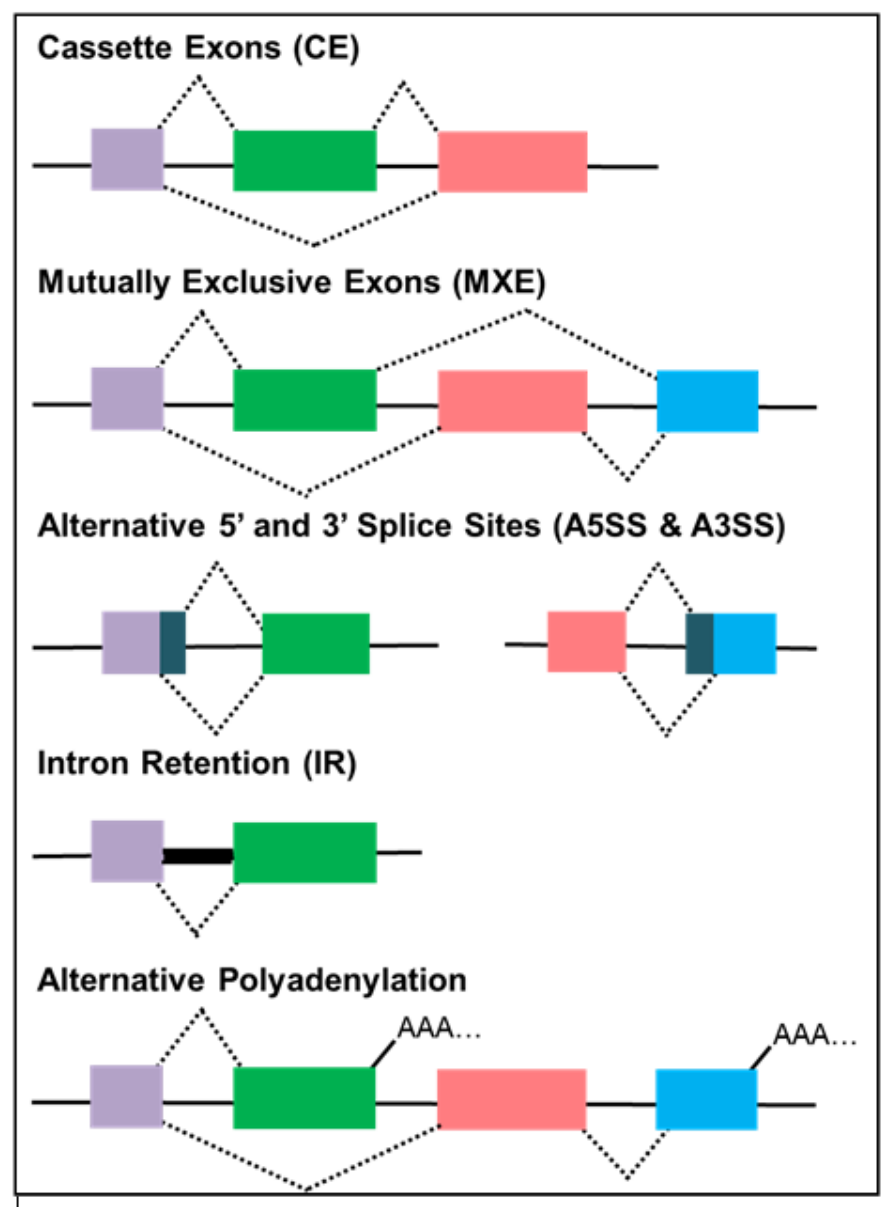
Figure 2. Frequent types of alternative splicing mechanisms. Alternative spliced mRNA produces mature transcripts, namely, cassette exons (CEs), mutually exclusive exons (MXEs), alternative 5 ′ or 3 ′ splice sites (A5SS and A3SS), intron retention (IR), and alternative polyadenylation (AP). Coloured boxes: exons; black lines: introns [31–35] . boxes: exons; black lines: introns